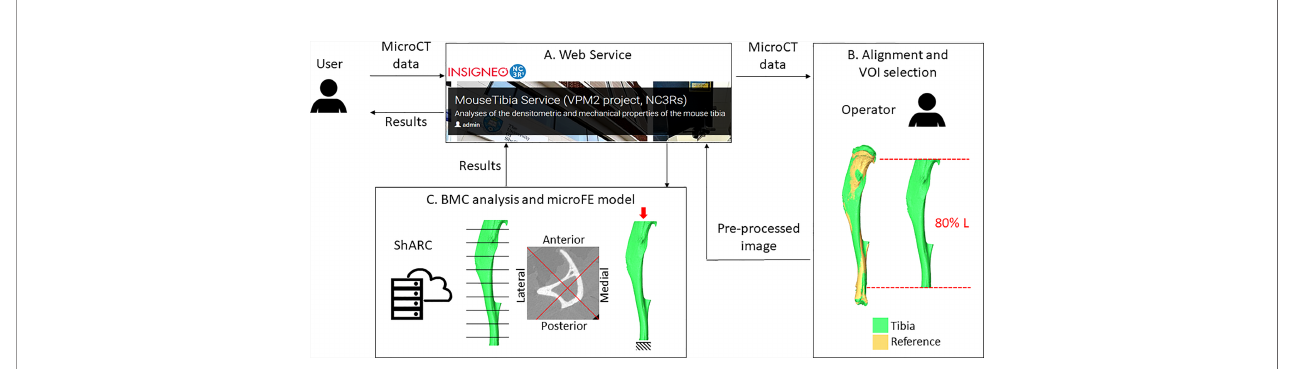
FIGURE 2 | Overview of the work fl ow. A user uploads microCT data to the webservice (A) . An operator downloads the image and performs the alignment and VOI selection (B) . Pre-processed images are uploaded back to the webservice. Bone mineral content (BMC) and microFE analyses (C) are run automatically in the HPC ShARC (Shef fi eld Advanced Research Computer). The results are sent back to the service and to